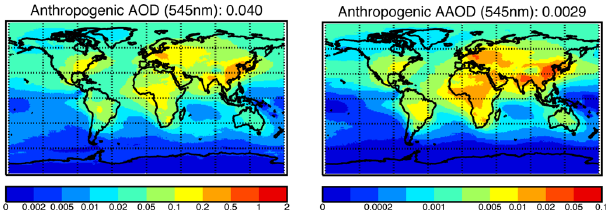
Fig. 20. Annual-mean prescribed anthropogenic aerosol optical depth (AOD) and absorption aerosol optical depth (AAOD) at 545nm as used in the FIX1 experiment.